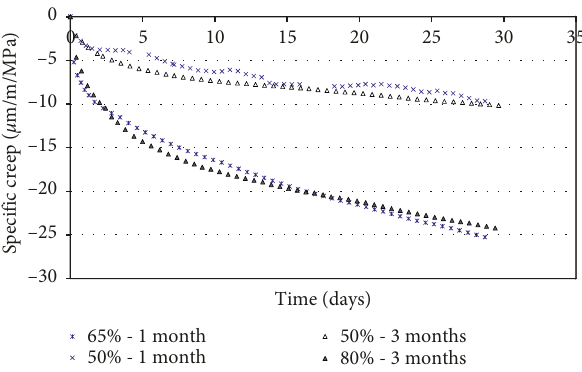
Figure 8: Axial specific creep strain vs.